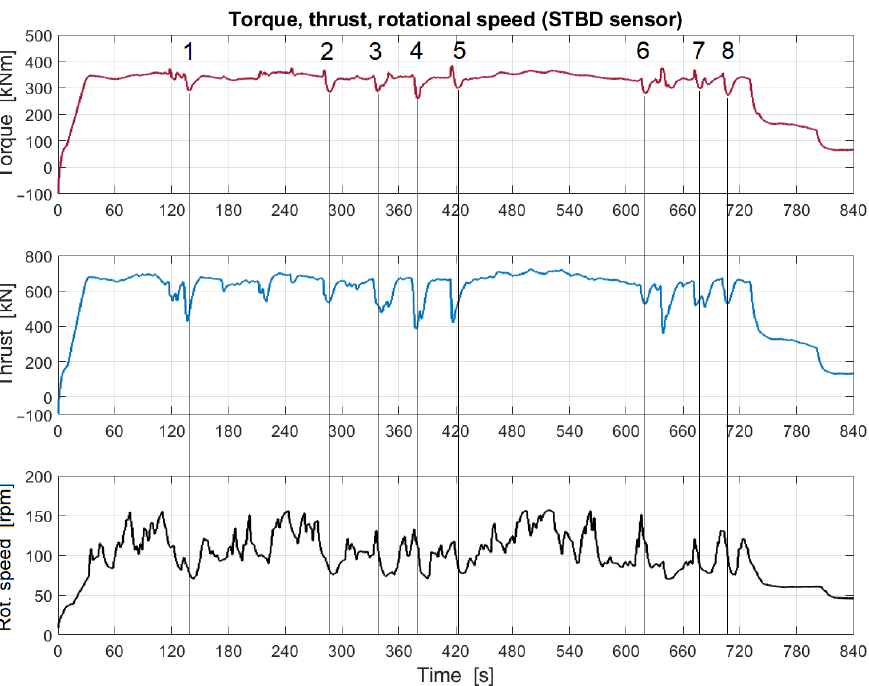
Figure 16. Time series of Q , T , and n during forward-direction ice navigation, on 17 October